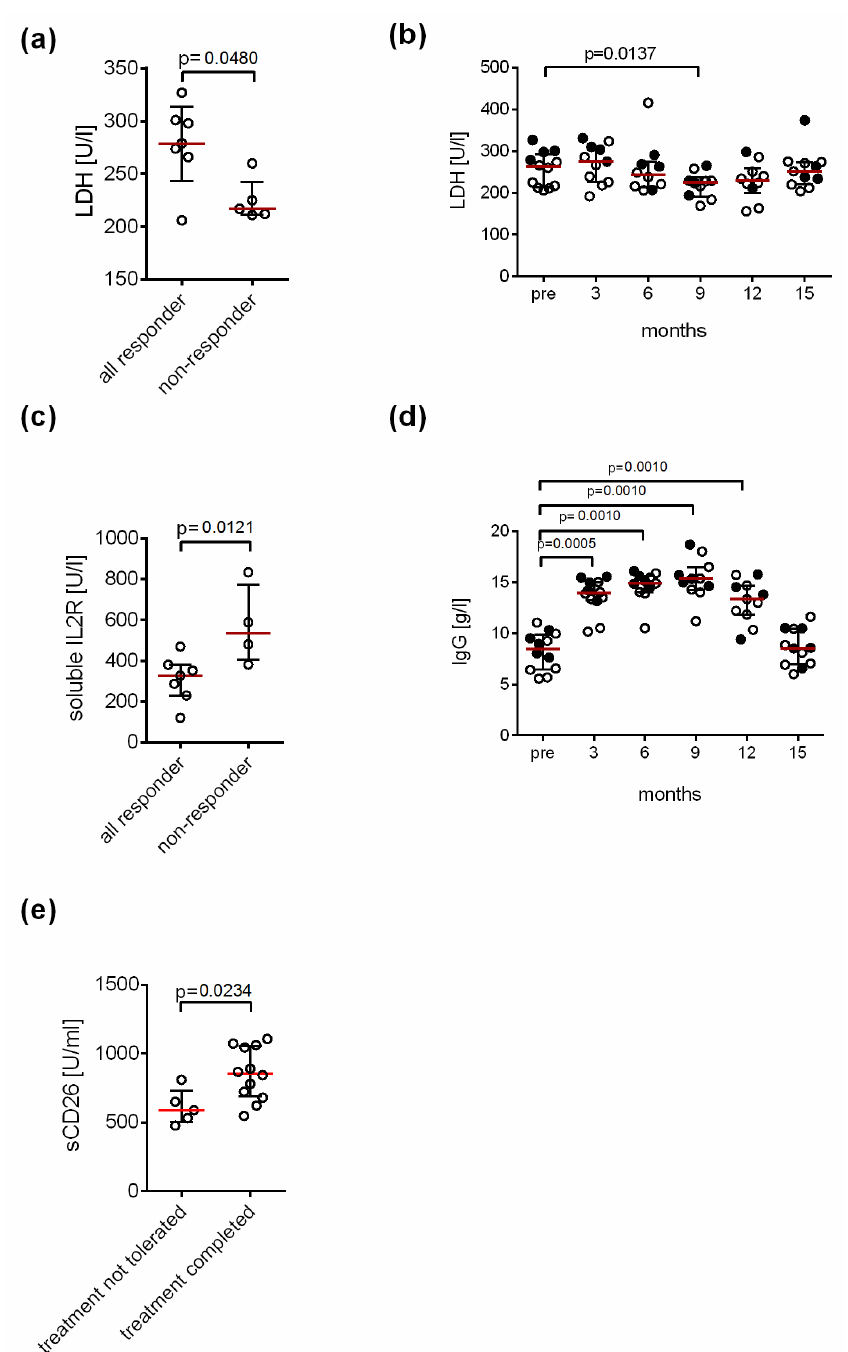
Figure 4. Association of biomarker with response and tolerability. Median and interquartile range pretreatment level of ( a ) LDH and ( c ) the soluble IL-2 receptor of responding patients including patients with a response at month 6 and 9 ( n = 7) compared to non-responders ( n = 5) are shown. Responder had significant higher LDH and lower soluble IL-2 receptor pretreatment level. Two tailed Mann – Whitney-U test was performed for statistical analysis. Median and interquartile range ( b ) LDH level and ( d ) IgG level of the patients before (pre), during (months 3 – 12) and 3 months after the treatment (month 15) are shown (responder indicated as filled circles). A two-tailed Wilcoxon matched-pairs signed-rank test was performed for statistical analysis. ( e ) Median and interquartile range of sCD26 level of patients not tolerating treatment ( n = 5) compared to those receiving 12 months of treatment ( n = 12) are plotted. Participants who did not tolerate the treatment had significant lower sCD26 levels. Two tailed Mann – Whitney-U test was performed for statistical analysis.